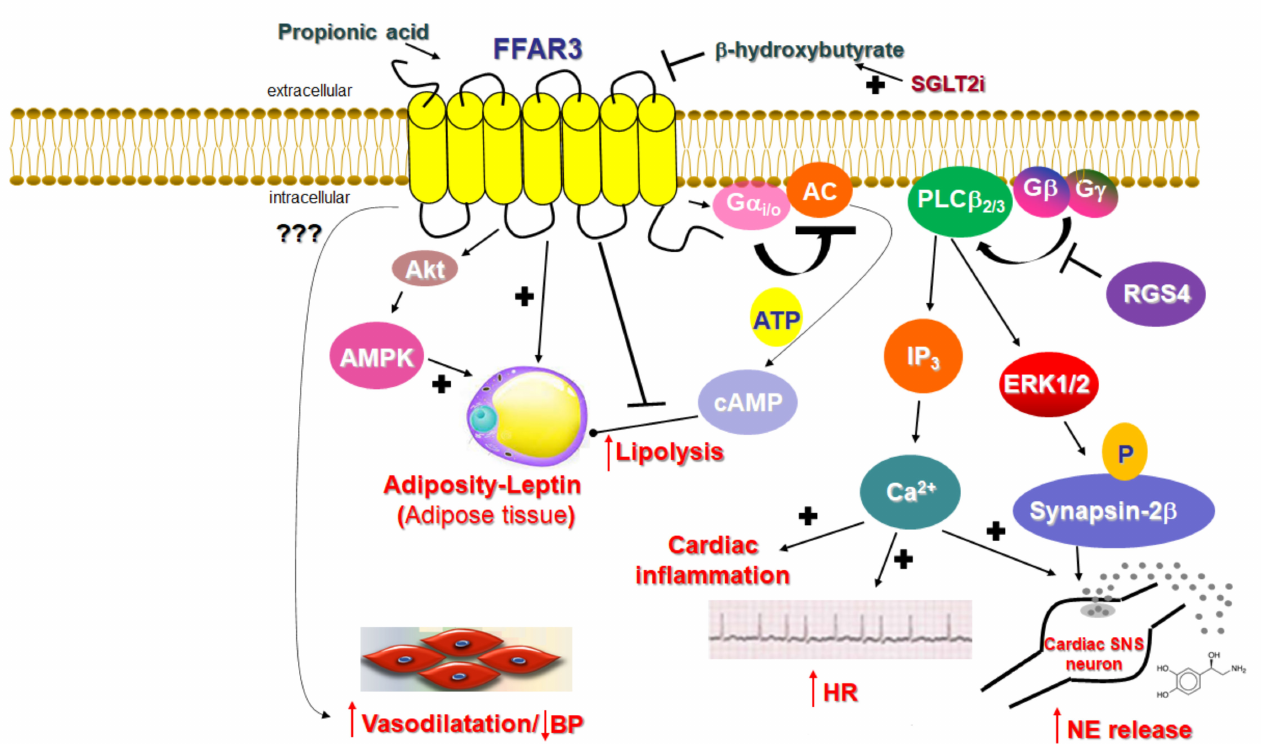
Figure 2. The cardiovascular physiology relevant to FFAR3 signaling. BP: Blood pressure; ERK: Extracellular signal-regulated (mitogen-activated protein, MAP) kinase; HR: Heart rate; IP 3 : Inositol 1 (cid:48) , 4 (cid:48) , 5 (cid:48) -trisphosphate; NE: Norepinephrine (noradrenaline); P: Phosphorylation; RGS4: Regulator of G protein signaling protein-4; SGLT2i: Sodium-glucose co-transporter type 2 inhibitor; SNS: Sympathetic nervous system; “???” indicates a signaling mechanism that is (currently) unknown. (See text for details and for all other molecular acronym